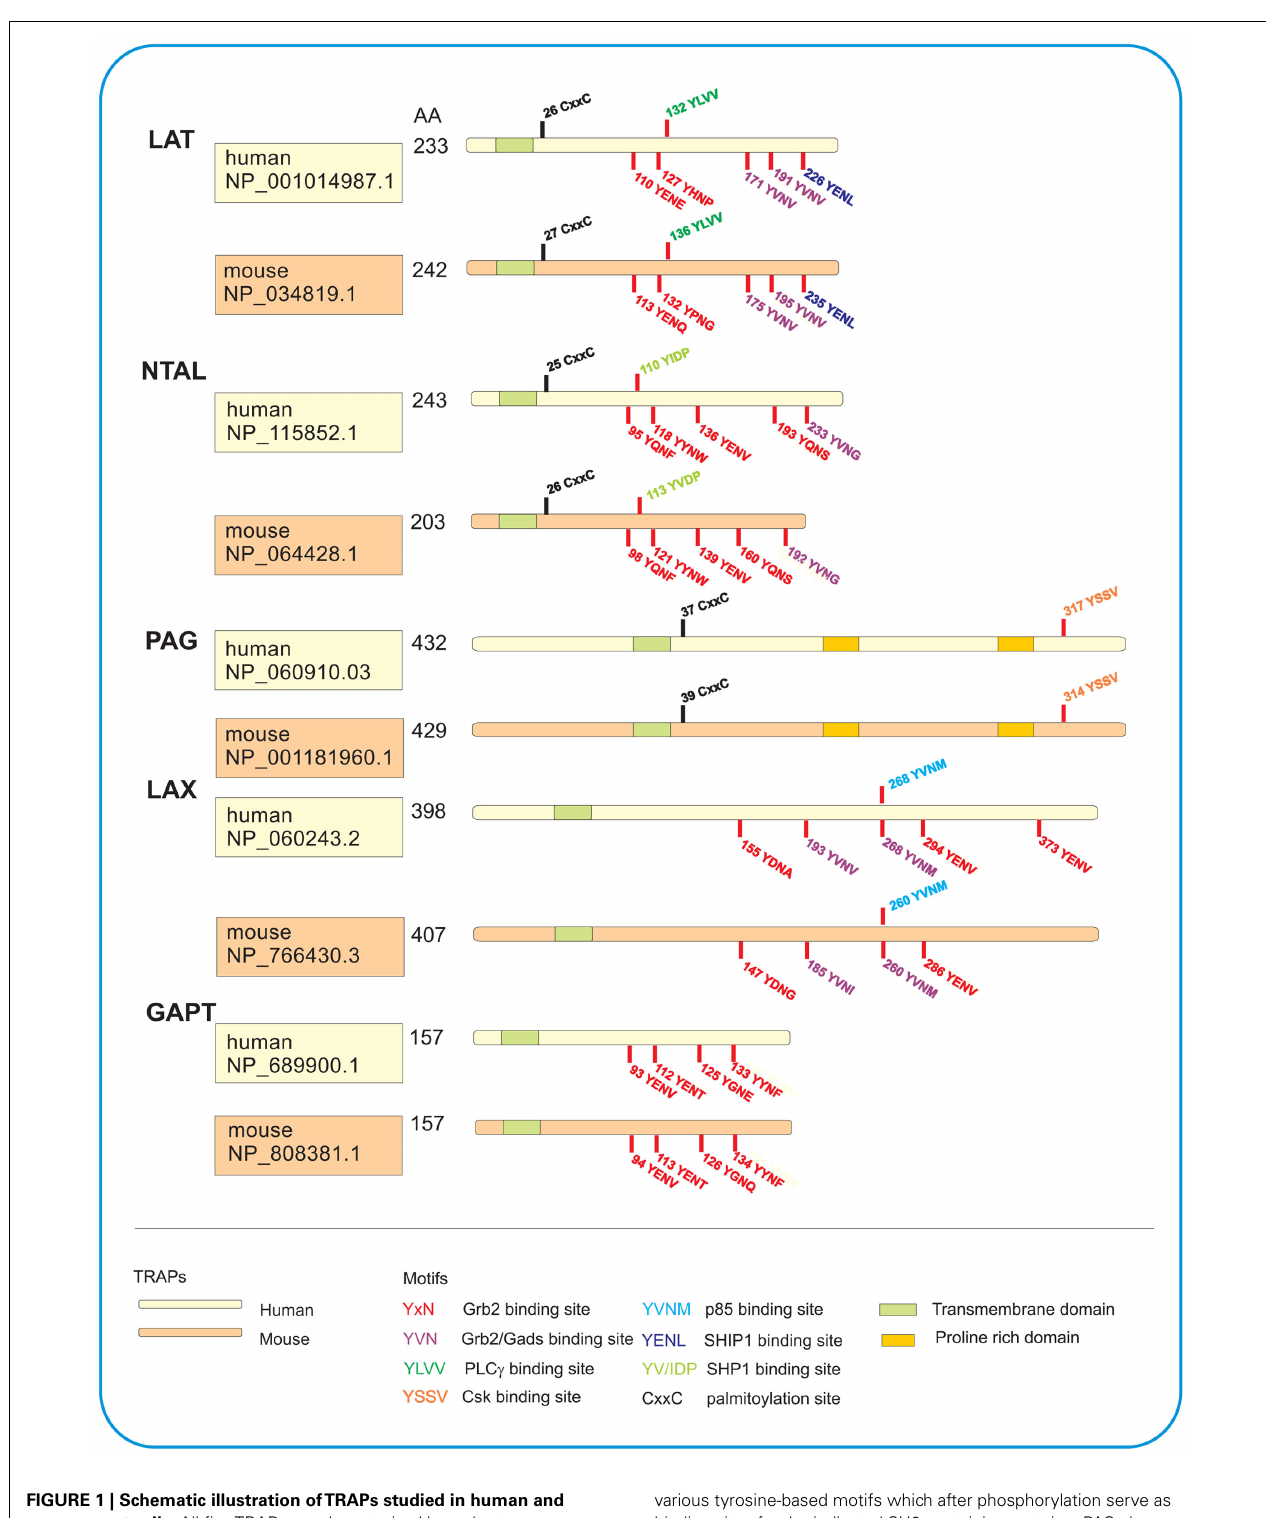
FIGURE 1 | Schematic illustration ofTRAPs studied in human and mouse mast cells. All fiveTRAPs are characterized by a short extracellular domain, a transmembrane domain, and a cytoplasmic domain with various motifs. LAT, NTAL, and PAG possess juxtamembrane CxxC palmitoylation site for their interactions with lipids and localization in detergent-resistant membranes. AllTRAPs have